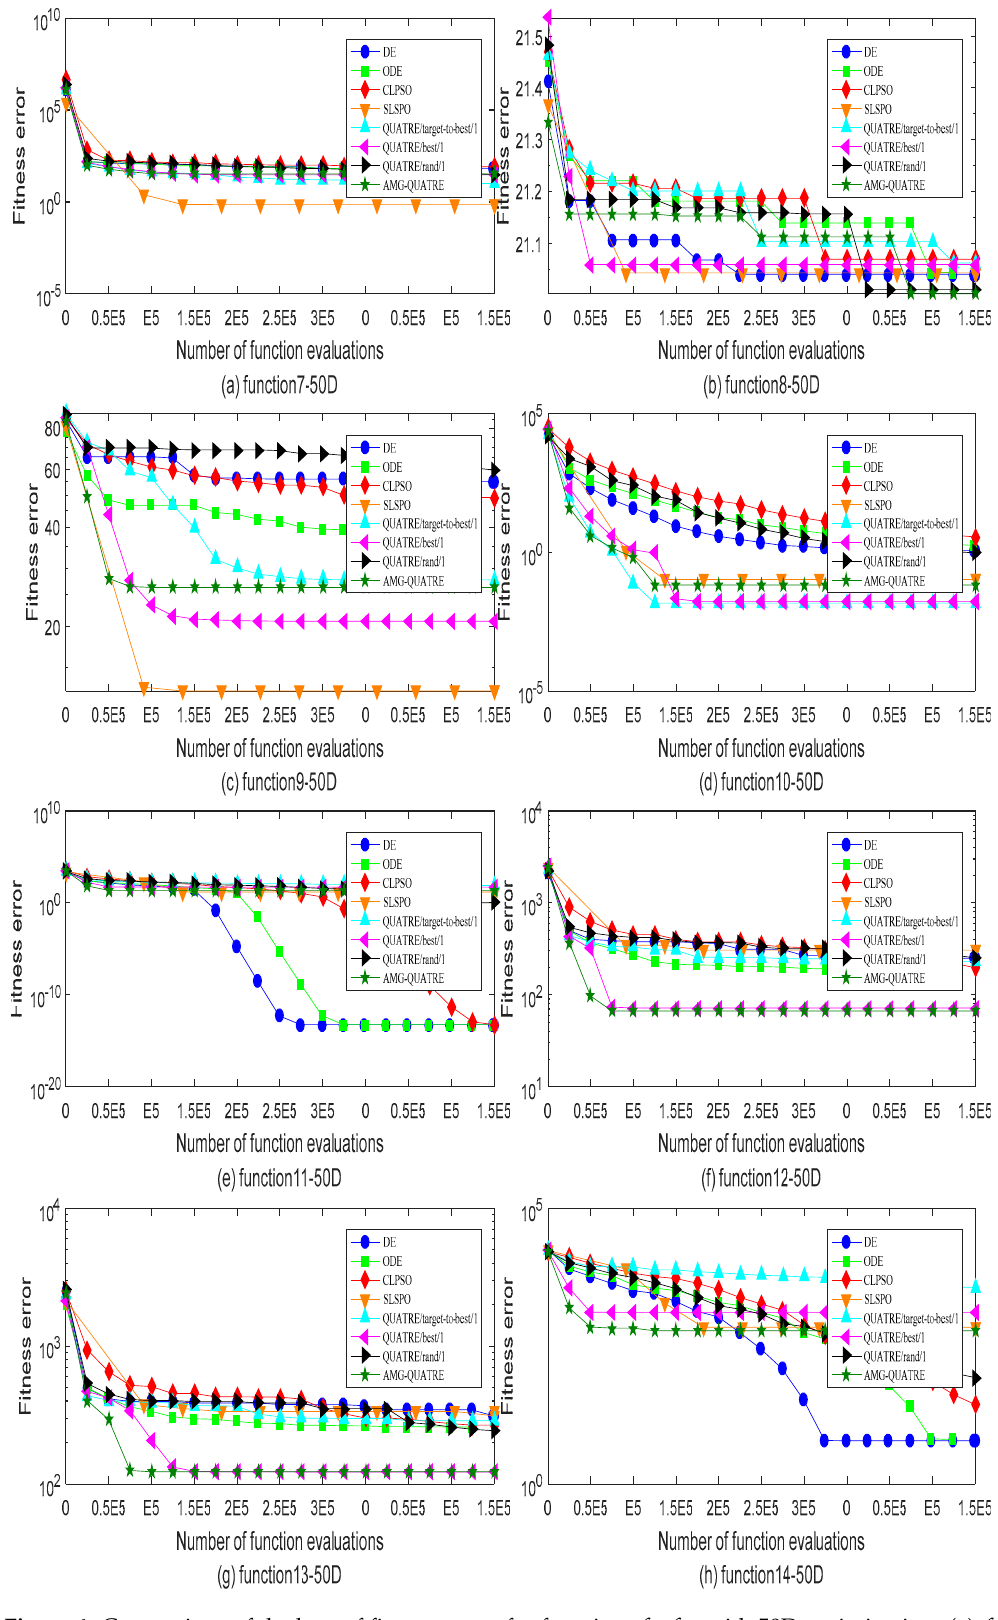
Figure 4. Comparison of the best of fitness errors for functions f 7 – f 14 with 50D optimization. ( a ) f 7